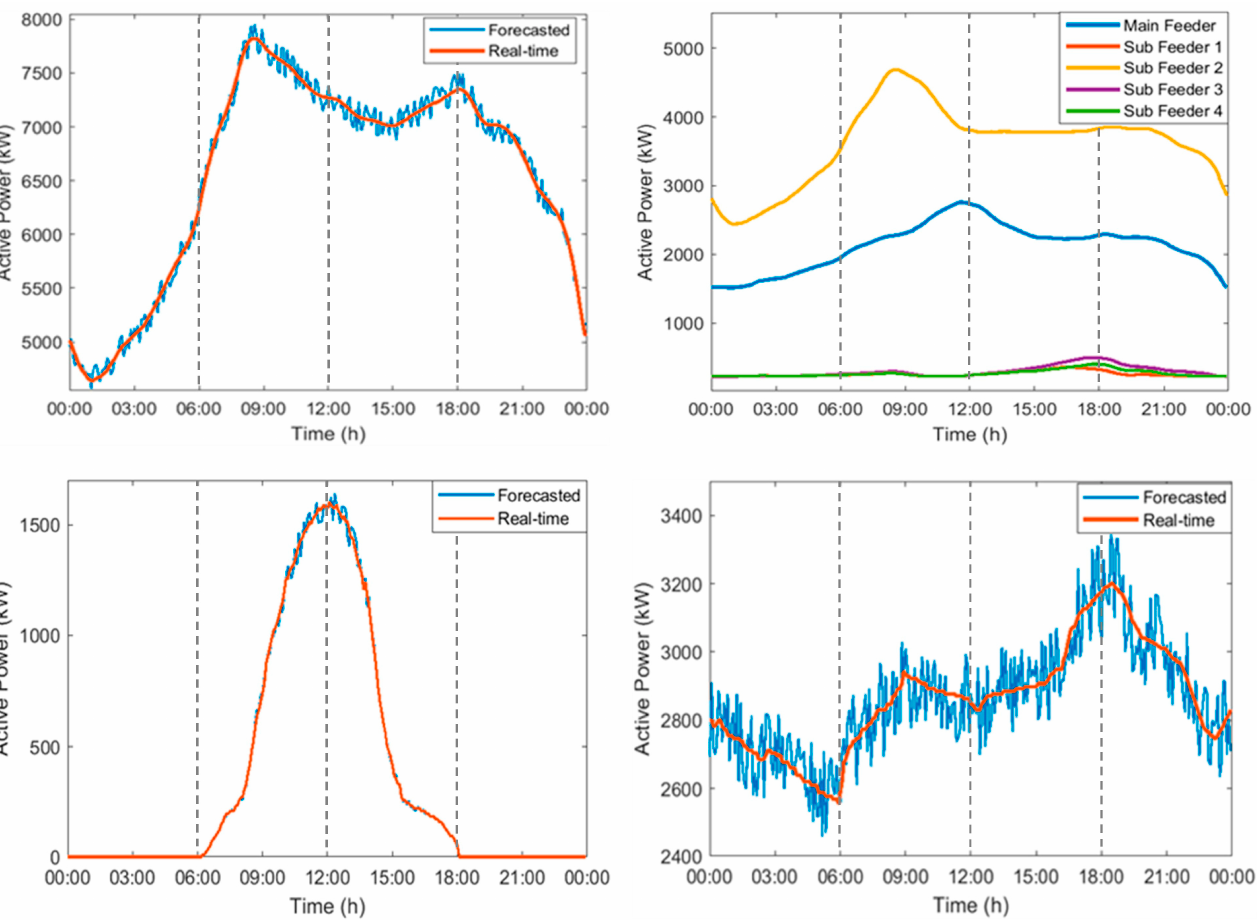
Figure 4. Forecasted and real-time data for 34-bus system: ( top ) total load profile and load profile by feeder; ( bottom ) PV and WT power profiles.